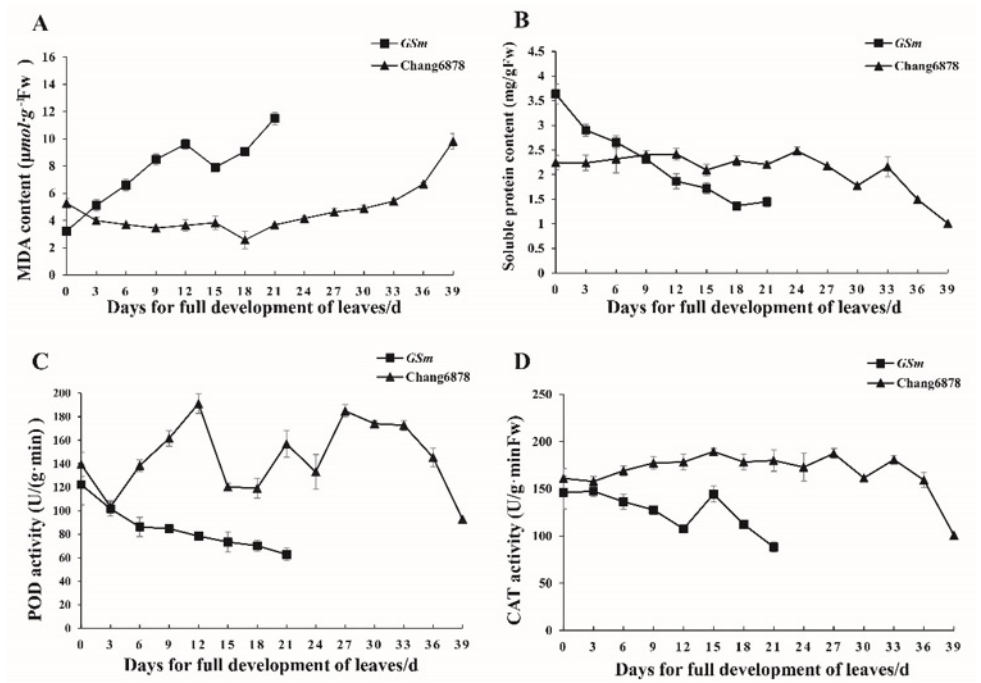
Figure 3. Senescence related physiological traits of GSm mutant and wild type. ( A ) Malondialdehyde content ( B ) soluble protein content ( C ) peroxidase activity ( D ) catalase activity. The vertical bar represents the standard error with three independent biological repetitions.